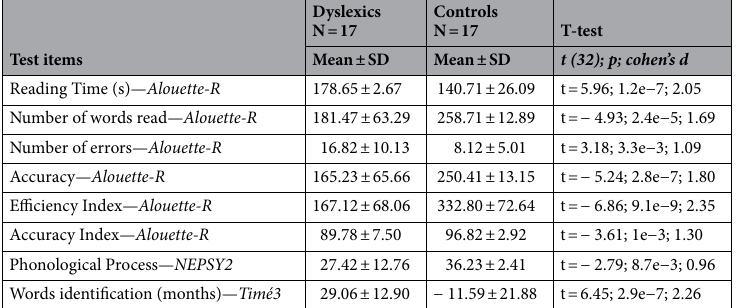
Table 1. Clinical Scores of Dyslexic and Control children at the Alouette, Nepsy2, and Timé3 tests (see Methods). As expected, controls outperformed dyslexics on all measures. Efficiency Index = (A × 180)/RT, where A stands for Accuracy and is the number of words correctly read (including self-corrections), 180 is the maximum time (in seconds) allowed for the test, and RT is the reading time. Accuracy Index: (A/NWR) × 100, where A stands for Accuracy, and NWR is the number of words